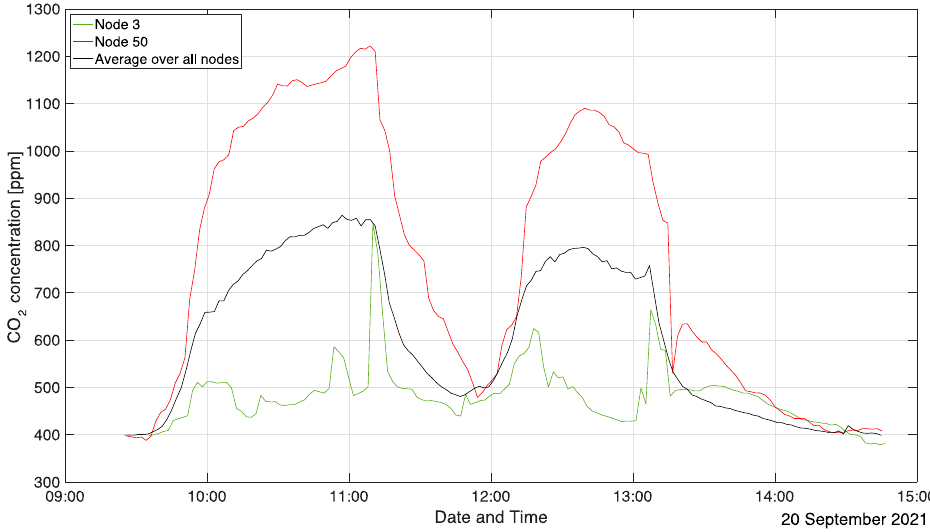
Figure 14. Local and average CO 2 concentrations in the inclined